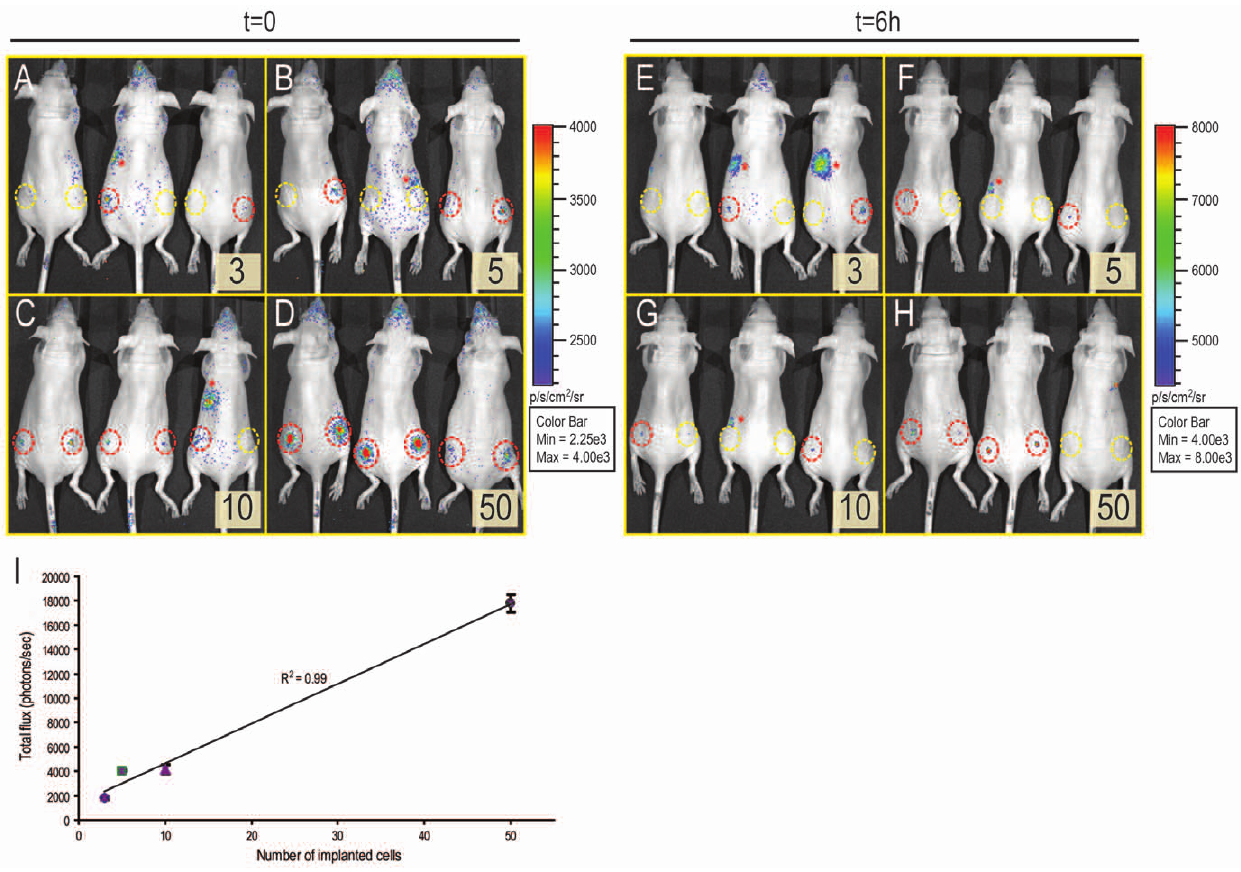
Figure 2. Detection of small numbers of 4T1-luc2-1A4 cells invivo . (A-D) Defined numbers of cells were implanted subcutaneously in dorsal flank regions of female nu/nu mice[1]. Each mouse received two implantations. Insets indicate the number of cells implanted. D-luciferin was injected into mice immediately after the implantation and bioluminescent images were taken (t=0) using an IVIS Spectrum (FOV; A, binning; small, f stop; 1, exposure time; 5 min). (E-H) After 6 hours of implantation, all mice were re-imaged using the same settings of IVIS Spectrum (t=6h). Red circles represent the implantation sites that had bioluminescent signals higher than autoluminescence. Yellow circles indicate the implantation sites that did not generate any meaningful signals possibly due to immediate cell death. (I) Correlation between the number of implanted cells and the total flux from the implantation sites. Bioluminescent signals were quantitated using Living Image software 3.0 and plotted against the numbers of cells. The measured intensity of bioluminescence was directly proportional to the number of implanted cells. Asterisks (*) indicate tissue